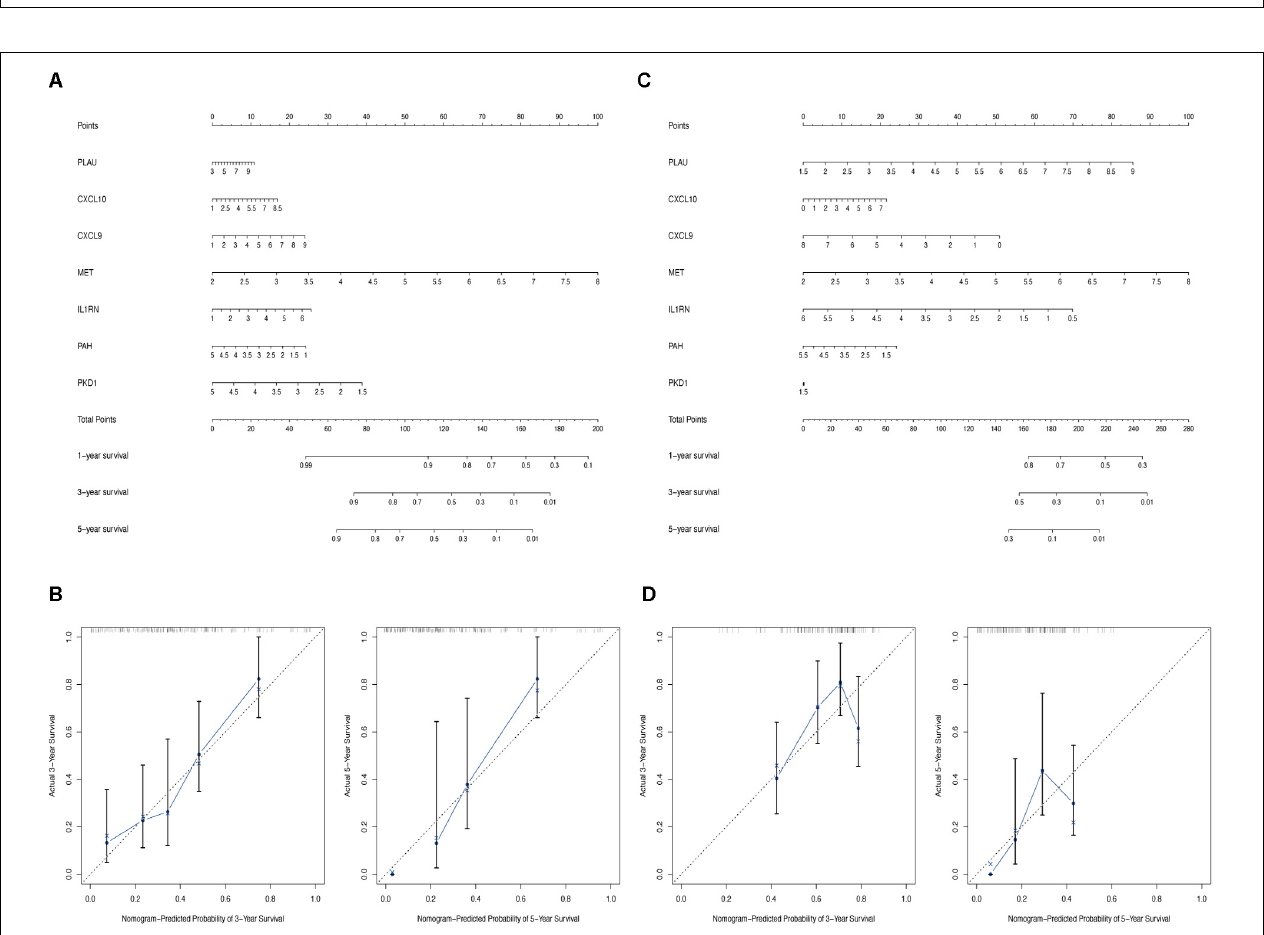
FIGURE 11 | Construction of nomogram based on the expression of 7 hub OS genes. The nomogram (A) and calibration plots (B) of hub OS genes in TCGA cohort. The nomogram (C) and calibration plots (D) of hub OS genes in validation cohort.